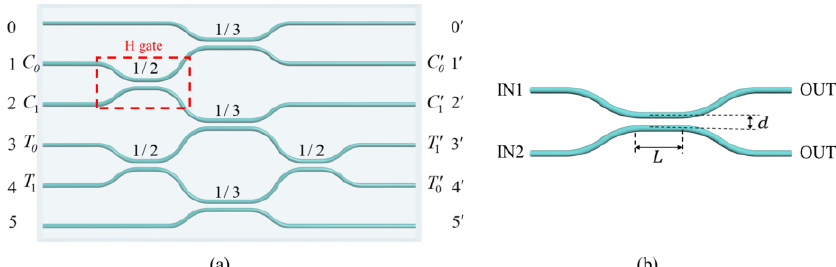
Figure 1. Schematic of the photonic quantum chip and the directional coupler (DC). ( a ) Schematic representation of a photonic chip composed of one H and one CNOT gate to generate path-encoded Bell states. The DC in the red dashed box represents an H gate. ( b ) Schematic representation of a waveguide directional coupler; IN1 and IN2 are the input ports, whereas OUT1 and OUT2 are the output ports of the device; L is the interaction length and d is the interaction distance in the coupling region of two adjacent waveguides.